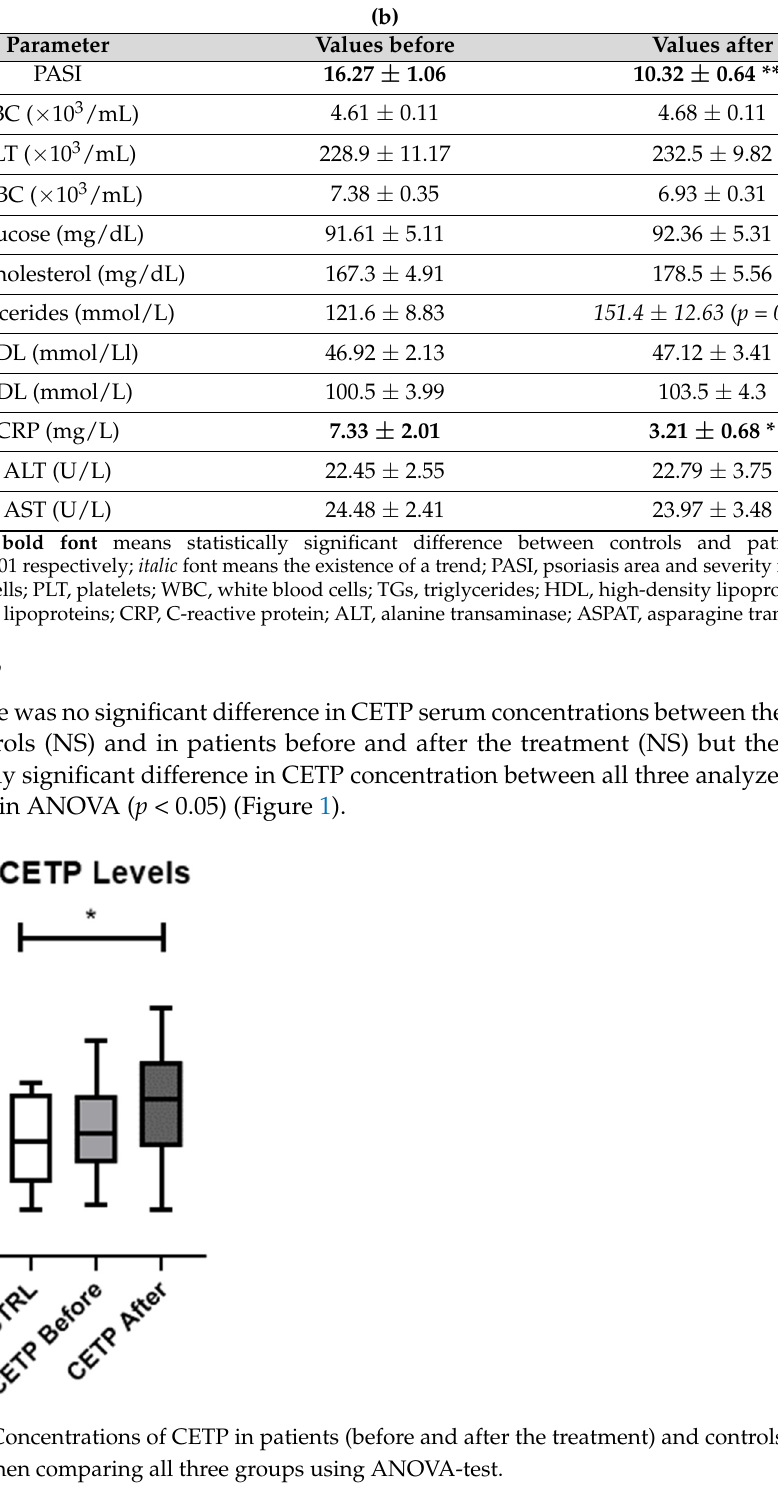
fore the treatment (R = 0.37, R = 0.38, R = 0.32, respectively, Figure 2). Moreover, after the (R = 0.34) and HDL concentration (R = 0.36), and also between CETP and AST activity (R = 0.39), along with a trend for ALT concentration (R = 0.31).